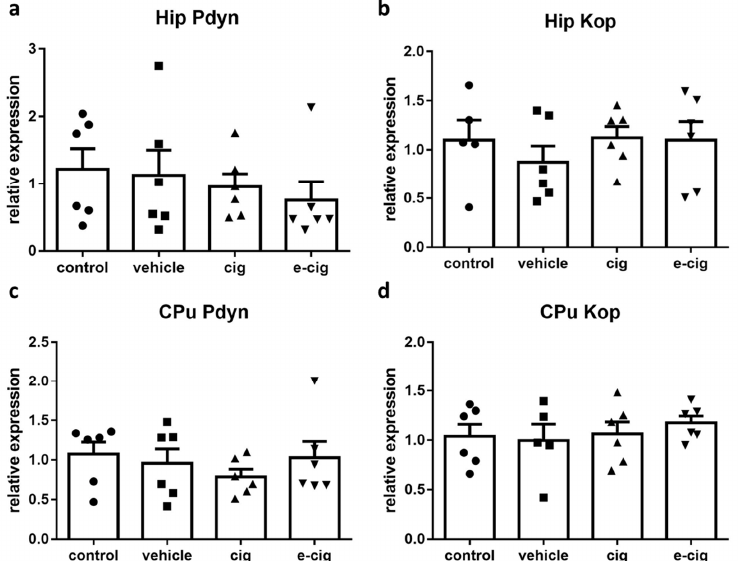
Figure 3. Relative mRNA levels of Pdyn ( a , c ) or dynorphin receptor Kop ( b , d ) after e-cigarette (e-cig, downward triangle) or cigarette (cig, upward triangle) exposure with respect to exposure to air (control, circle) or the e-cigarette administration vehicle (vehicle, square). The results displayed in panels a and b were obtained in the hippocampus, while panels c and d show the results of the CPu. The mice were exposed to cigarettes or e-cigarettes for 7 weeks, followed by a 60-day withdrawal. n = 4–6 for each group. Hip: hippocampus; CPu: caudate-putamen.